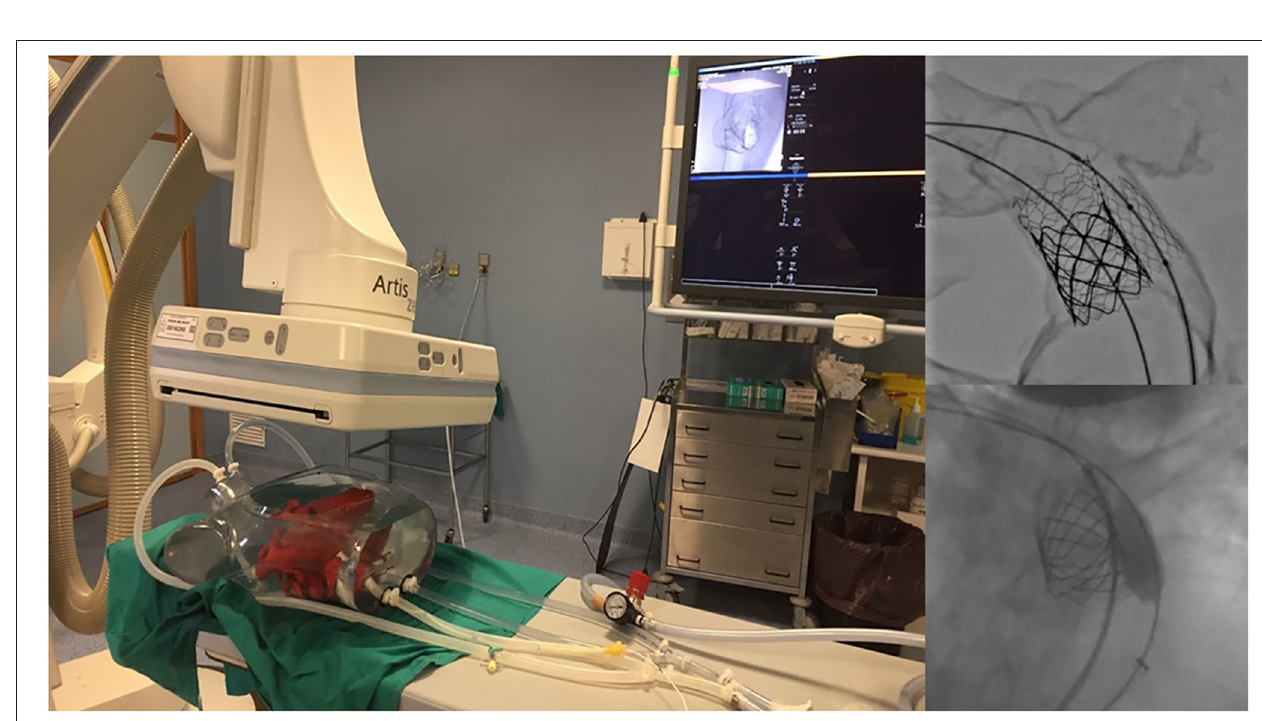
FIGURE 5 | Examples of heart models for surgical and interventional planning. Double outlet right ventricle (Case 135), internal vision from the left ventricle (upper left). Double outlet right ventricle (Case 133), external view (upper right). Testing of the personalized catheterization simulator in real conditions. Two fluid inlets (superior and inferior cava vein) and two fluid outlets (aortic arch and descending aorta) (down left). Percutaneous pulmonary valve implantation in a patient with severe right ventricle dilatation. Interventional planning with 3D printed model and real intervention in the patient (down right).